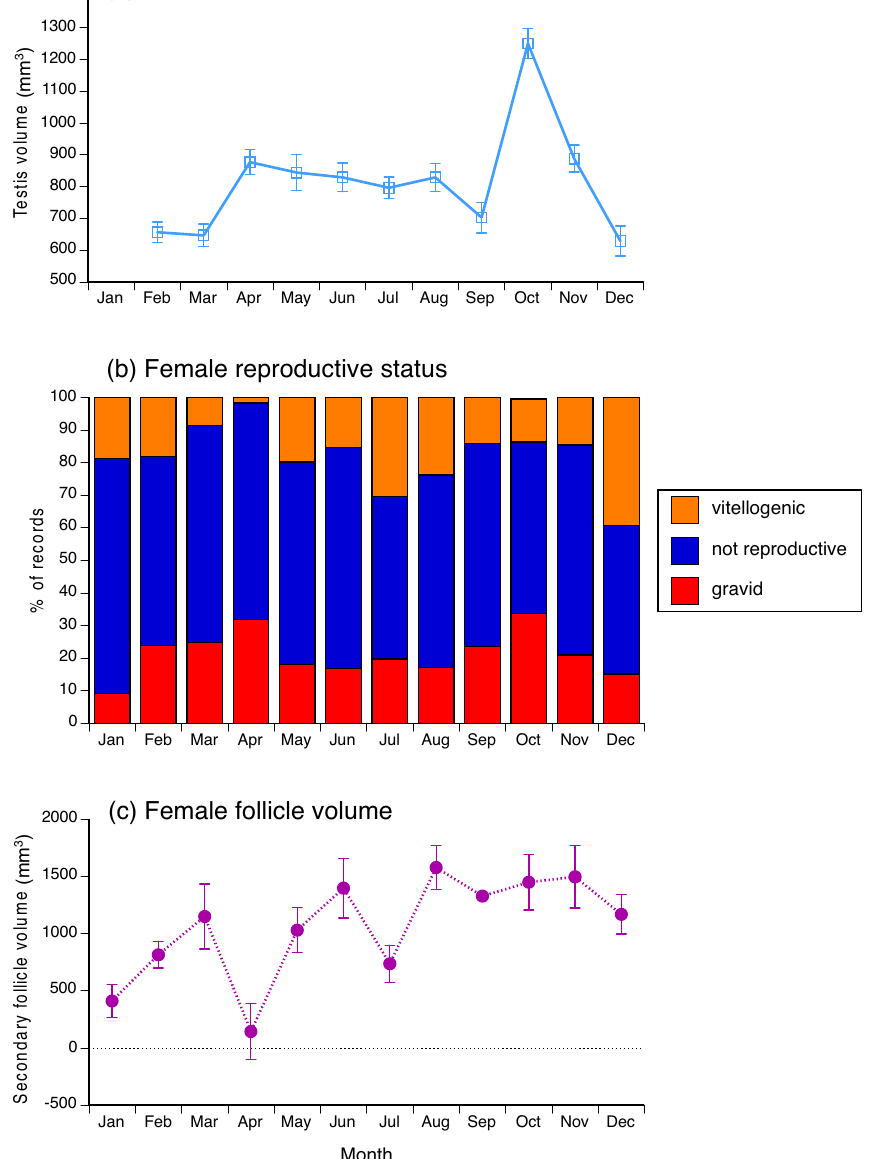
Figure 4. Monthly variation in reproductive traits of Asian bockadams ( Cerberus schneiderii ) examined at processing facilities near the city of Cirebon in West Java. The upper panel ( a ) shows ln-transformed values for volume of the right testis in males. The middle panel ( b ) shows relative numbers of adult female snakes that were classed as vitellogenic, gravid, or non-reproductive. The lower panel ( c ) shows ln-transformed values for mean volume of enlarged ovarian follicles. Points in ( a ) and ( c ) show mean values and associated standard errors for each